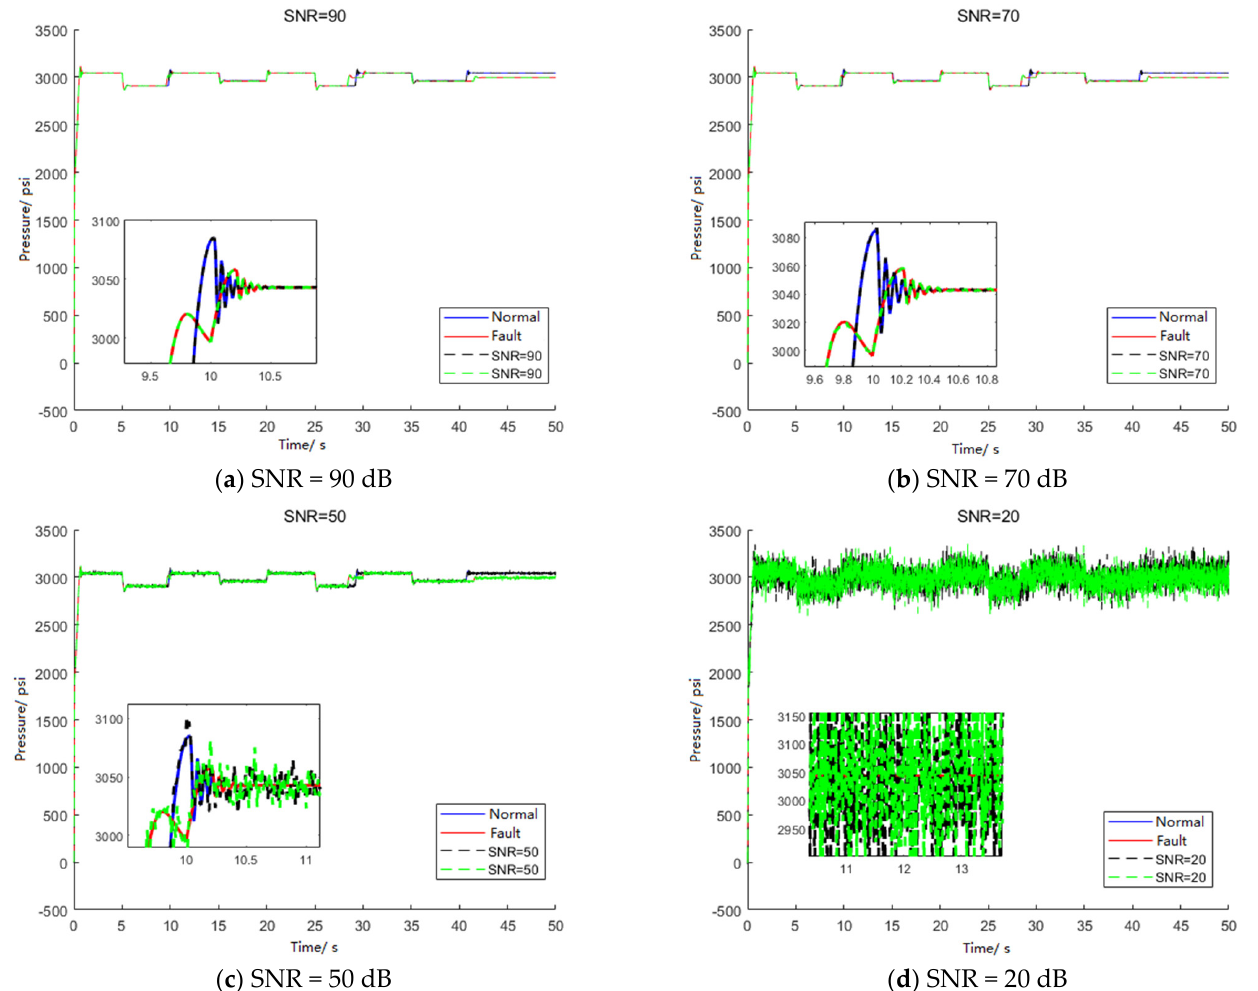
Figure 11. Comparison of fault state and normal state signals in different noise environments.